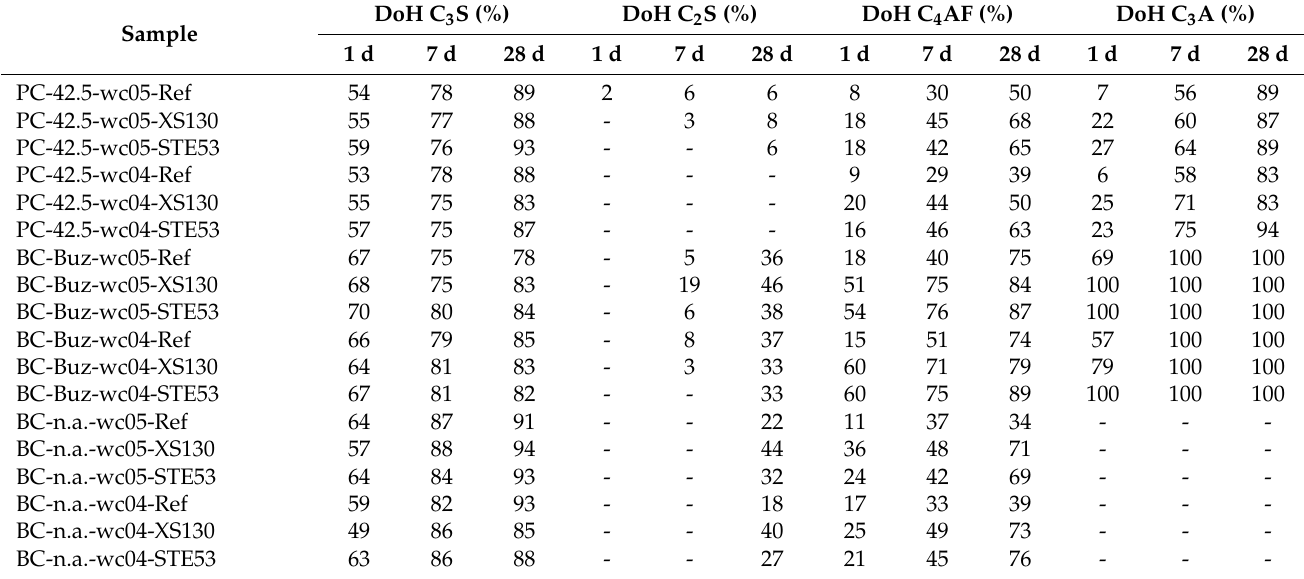
Table 1. Degree of hydration of the clinker phases for all studied